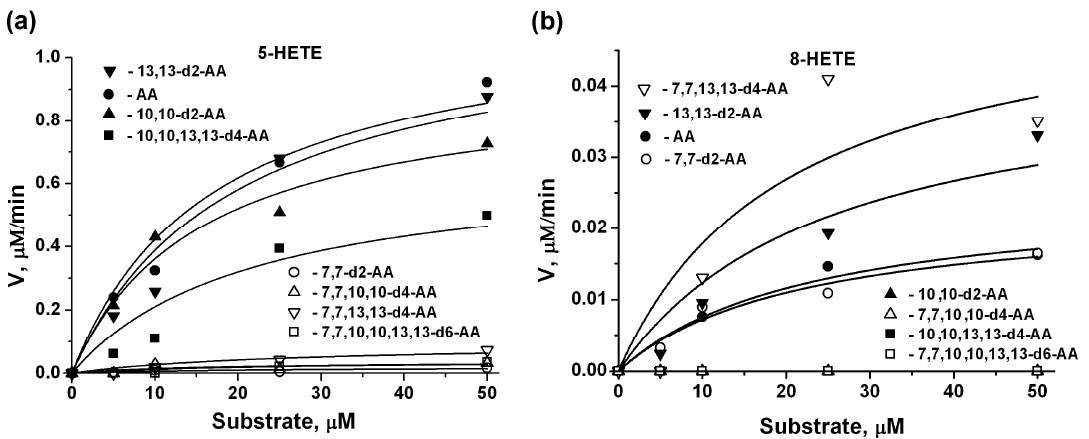
Figure 3. Steady state kinetics of 5-LOX with arachidonic acid (AA) and deuterated arachidonic acids monitoring the formation of 5-HETE ( a ) and 8-HETE ( b ) by using UPLC-MS/MS. Details are described in Experimental Procedures. All experiments were conducted in triplicate. Standard deviations are indicated in Table 2.